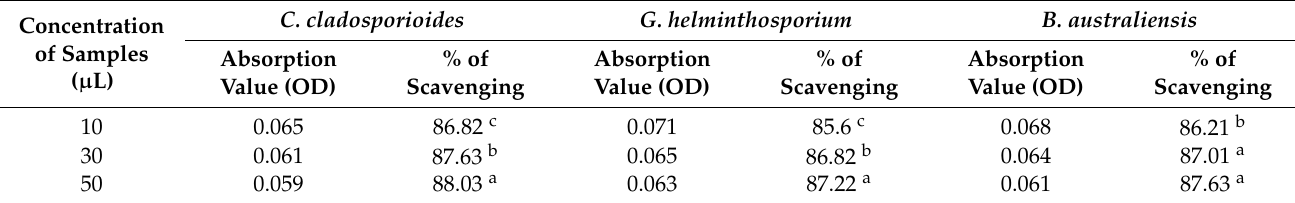
Table 8. Nitric oxide antioxidant scavenging activity of the ethyl acetate (extracellular) extract of Cladosporium cladosporioides, Graminicolous helminthosporium , and Bipolaris australiensis . Data are represented as means ± SD of three replicates. Numbers within a column followed by the same letters are not significantly different according to Duncan’s multiple range test at p ≤ 0.05.